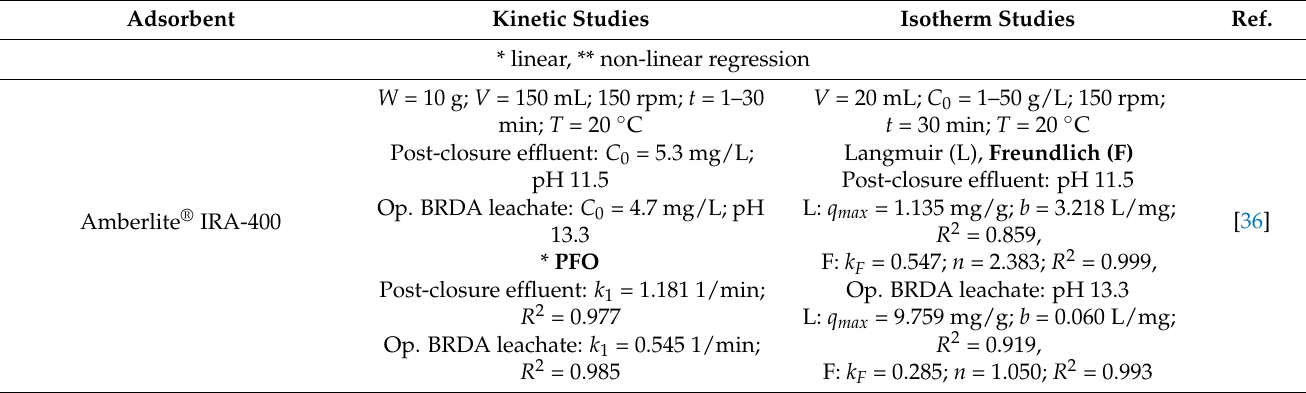
Table 4. Kinetic and equilibrium studies for vanadium on ion exchangers and biochar—comparison. Adsorbent Kinetic Studies Isotherm Studies